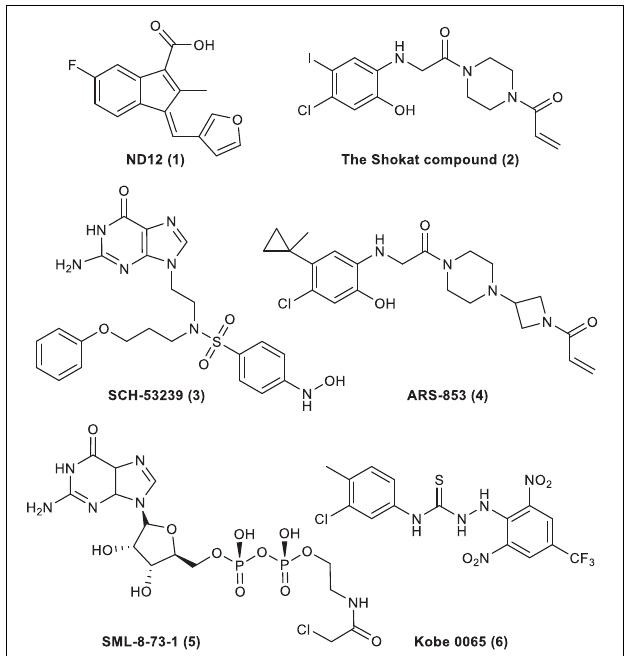
FIGURE 1 | Compounds that have been reported to bind to Ras. (1). ND12 is a sulindac derivative that blocks the growth of Ras-transformed cells (Karaquni et al., 2002a,b). (2). The Shokat compound was identified by using a disulfide fragment-based screening approach with GDP-bound K-Ras (G12C) (Ostrem et al., 2013). (3). SCH-53239 was designed to inhibit guanine nucleotide exchange (Taveras et al., 1997). (4). ARS-853 is a selective